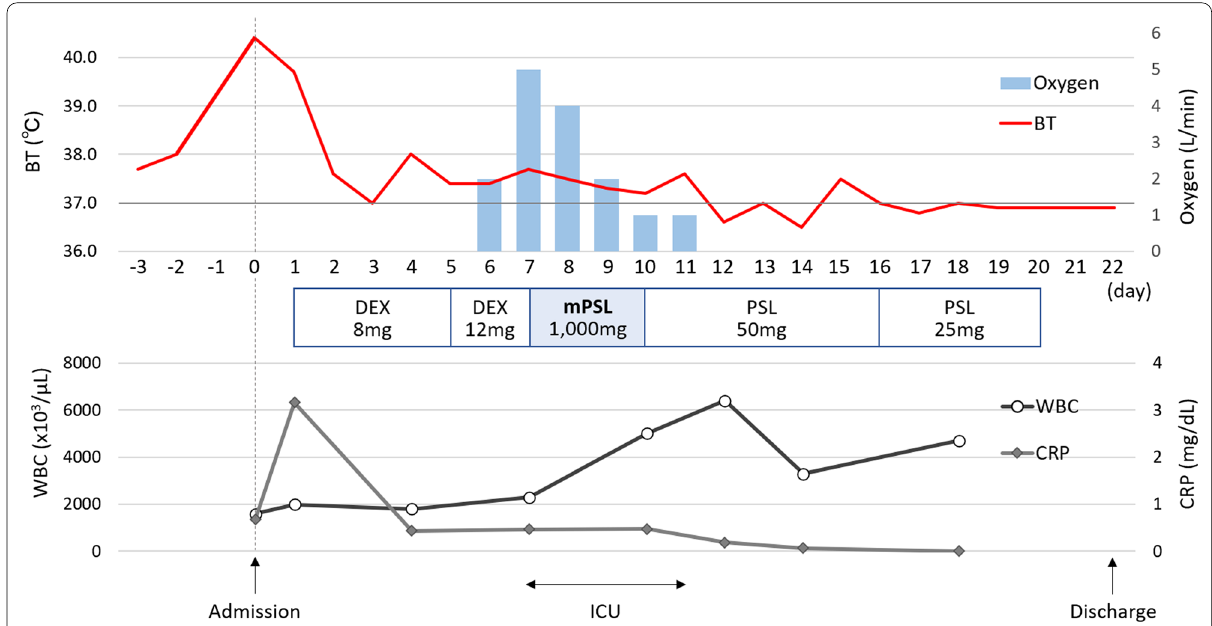
Fig. 2 Clinical course of the patient. BT: body temperature; WBC: white blood cell; CRP: C-reactive protein; ICU: intensive care unit; DEX: dexamethasone; mPSL: